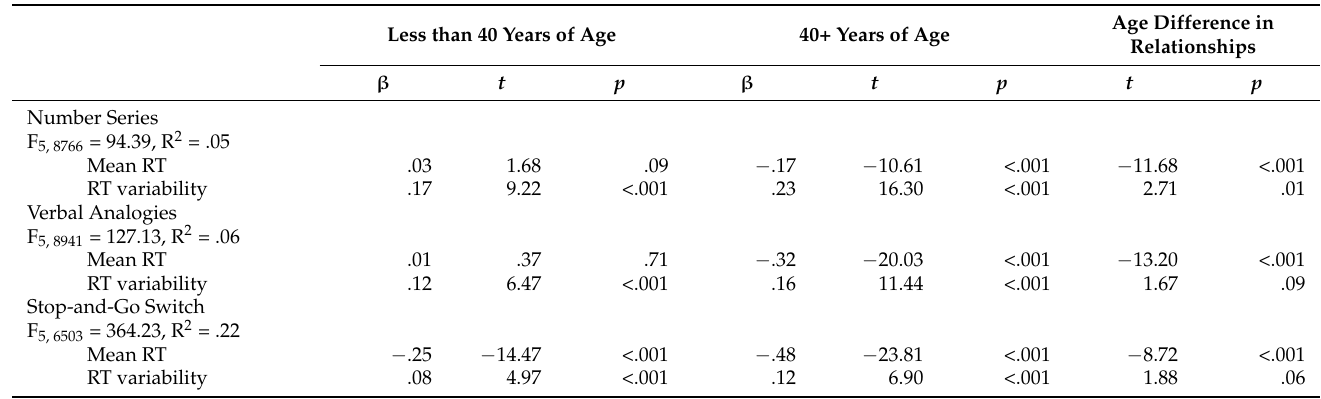
Table 3. Age differences in relationships between cognitive test scores and survey item response time components derived from the location-scale